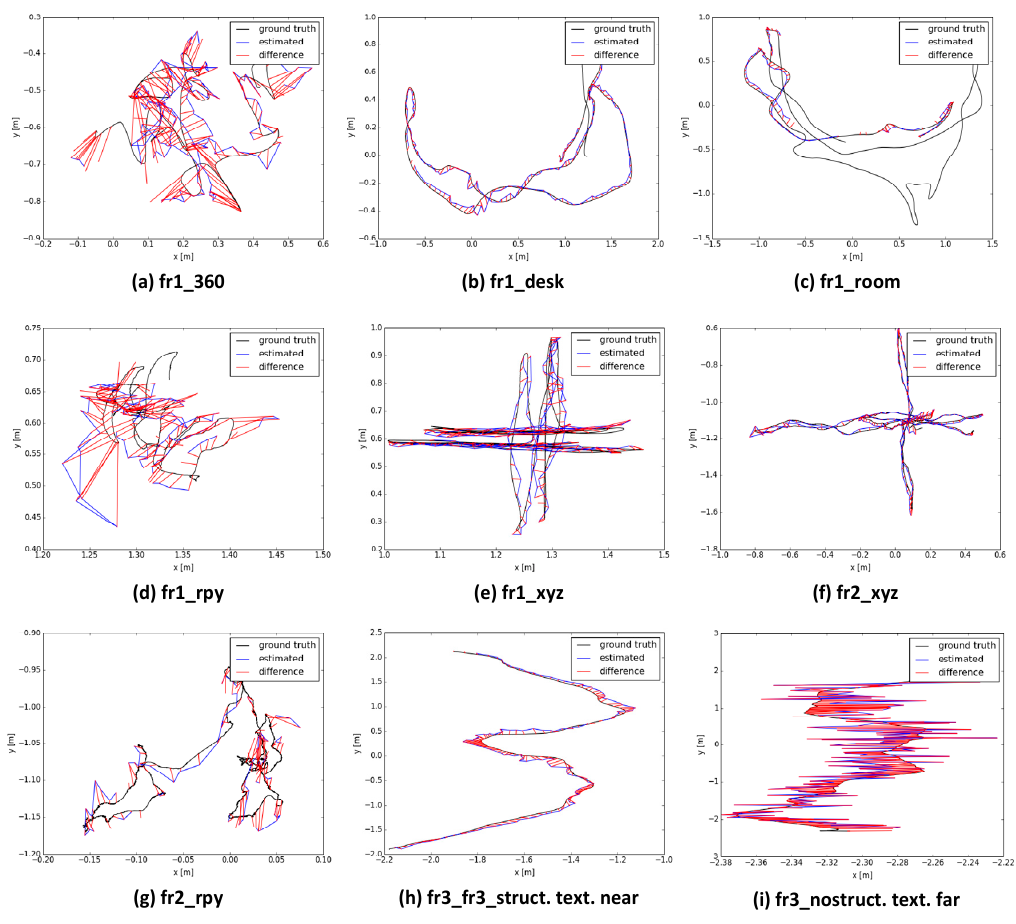
Figure 5 . Comparison of estimated and ground truth trajectories. Figure 5. Comparison of estimated and ground truth Table 1. Comparisons of the median (max) absolute trajectory error (ATE; in mm) for incremental registration of RGB-D sequences of the Freiburg Benchmark Dataset. Best results in bold.